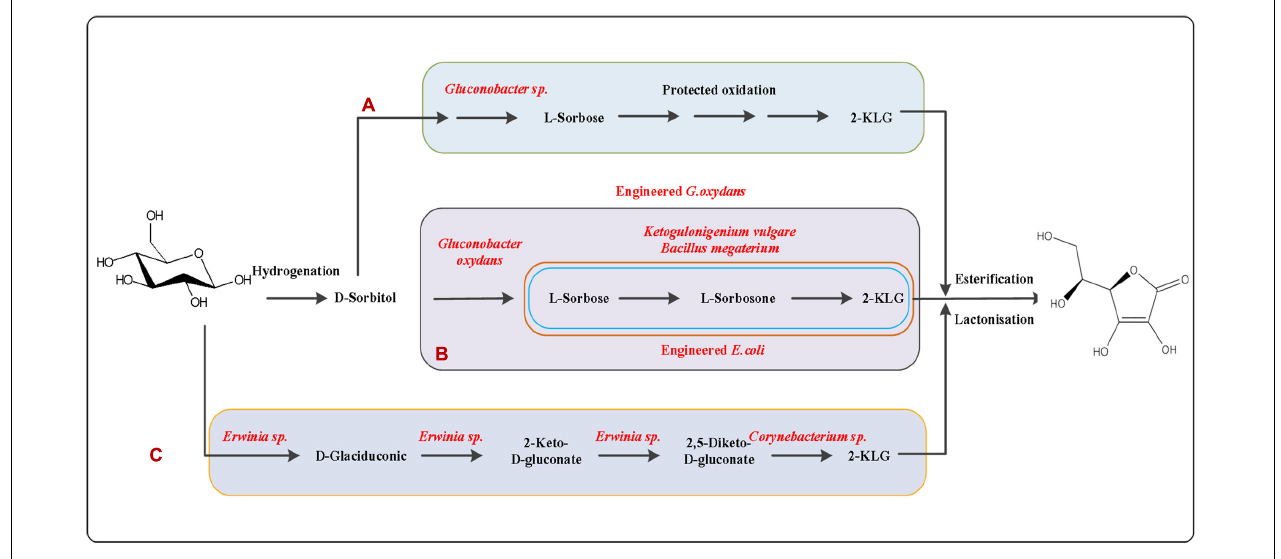
FIGURE 2 | L -ascorbic acid production pathway. (A) Classical Reichstein process: the seven-step Reichstein process involving six chemical transformations and one fermentation by Gluconobacter oxydans . (B) Two steps fermentation by mixed bacteria: G. oxydans , Bacillus megaterium and Ketogulonicigenium vulgare ; (C) 2,5-Diketo- D -gluconic acid pathway: mixed or two stage fermentations with Erwinia sp. and Corynebacterium sp. or other species for the direct synthesis of 2-KLG.